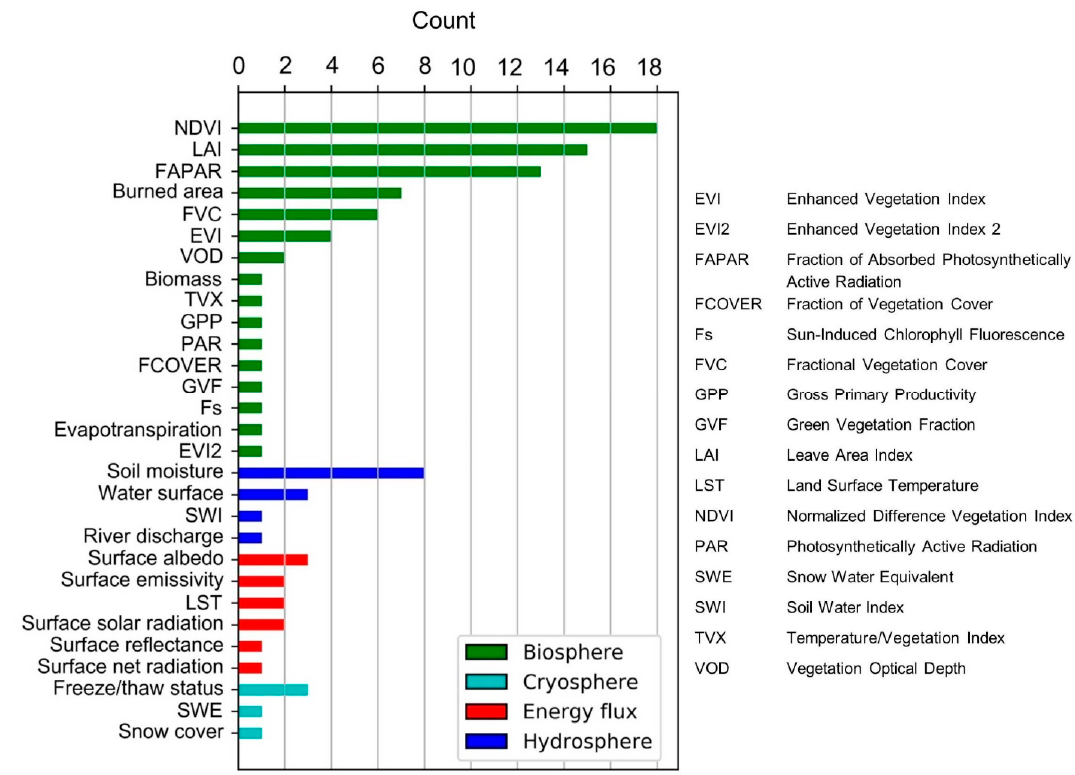
Figure 6. Utilization frequency of time-series-derived variables in the reviewed studies.